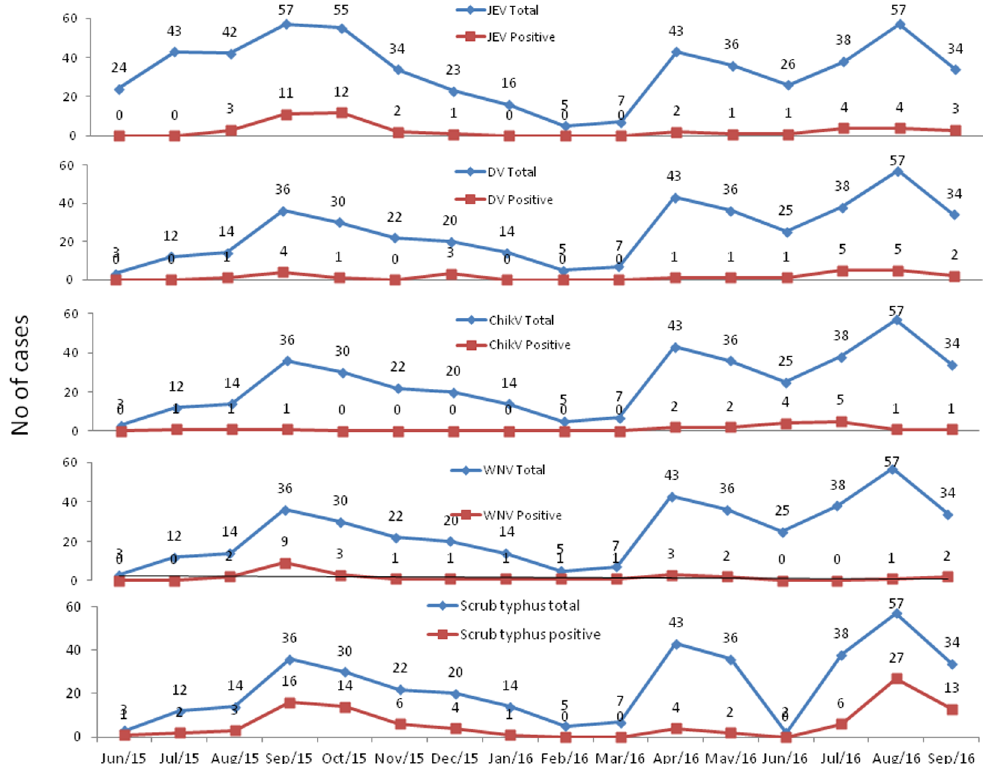
Fig 5. Seasonal distribution of total AES cases referred and arbovirus and scrub typhus positivity.